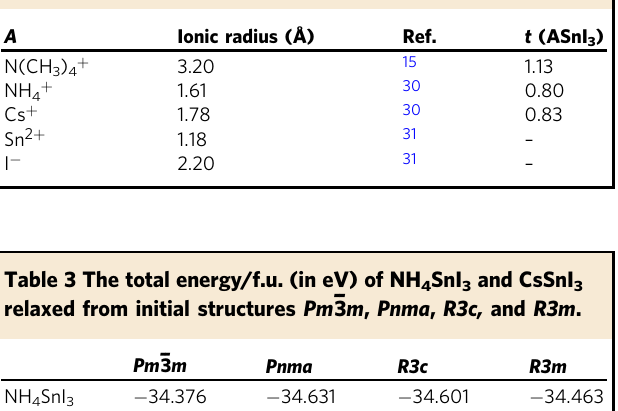
Fig. 5. The calculated absorption coef fi cient increases sharply as the photon energy is above the band gap, so N(CH 3 ) 4 SnI 3 can absorb visible light effectively and act as a potential high- ef fi ciency light-absorber semiconductor in solar cells.